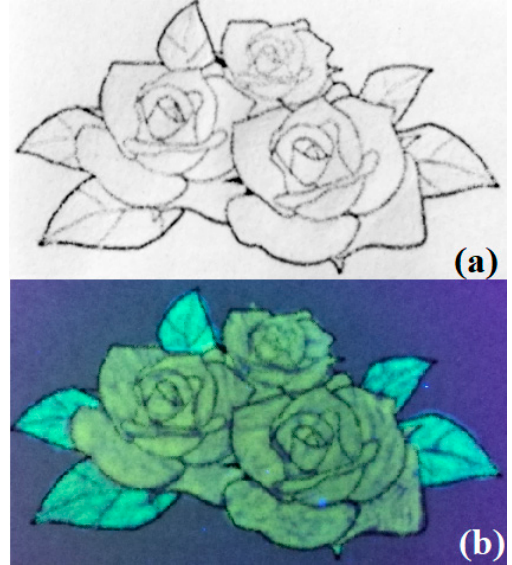
Figure 10. Photos of pictures painted by y-SiQDs and g-SiQDs. Photo ( a ) was photographed under daylight and ( b ) was photographed under UV-light (365 nm).